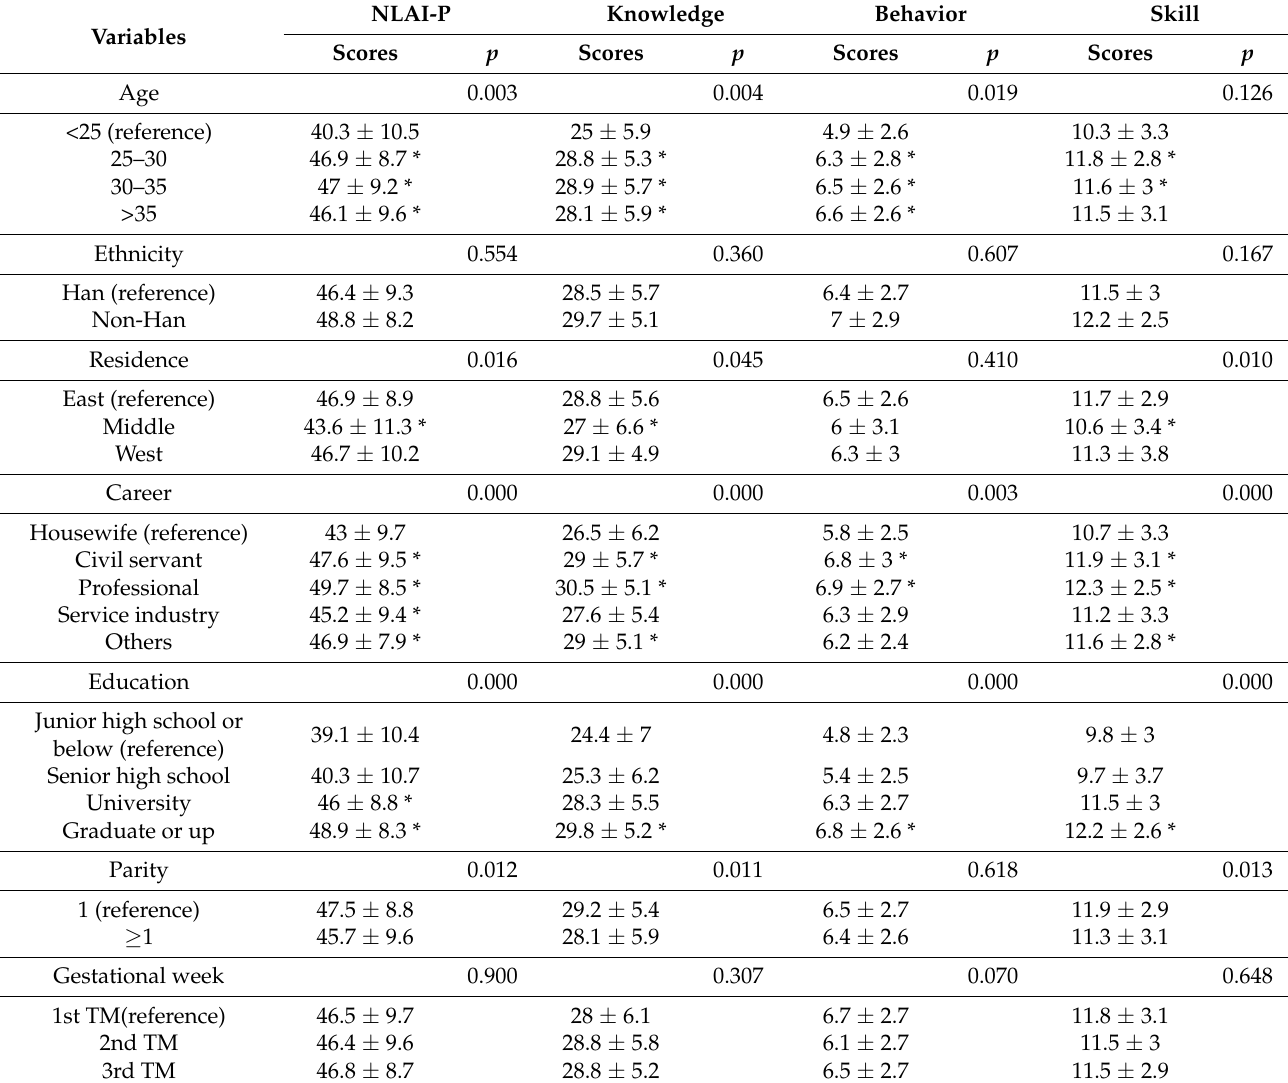
Table 9. The potential factors influencing NL of Chinese pregnant women.